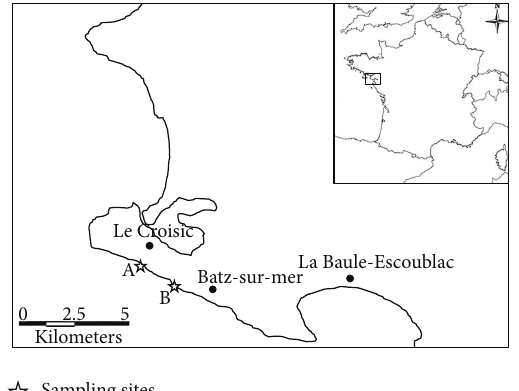
Figure 1: Location of the two field sampling sites of Grateloupia turuturu along the Atlantic Coast (France).